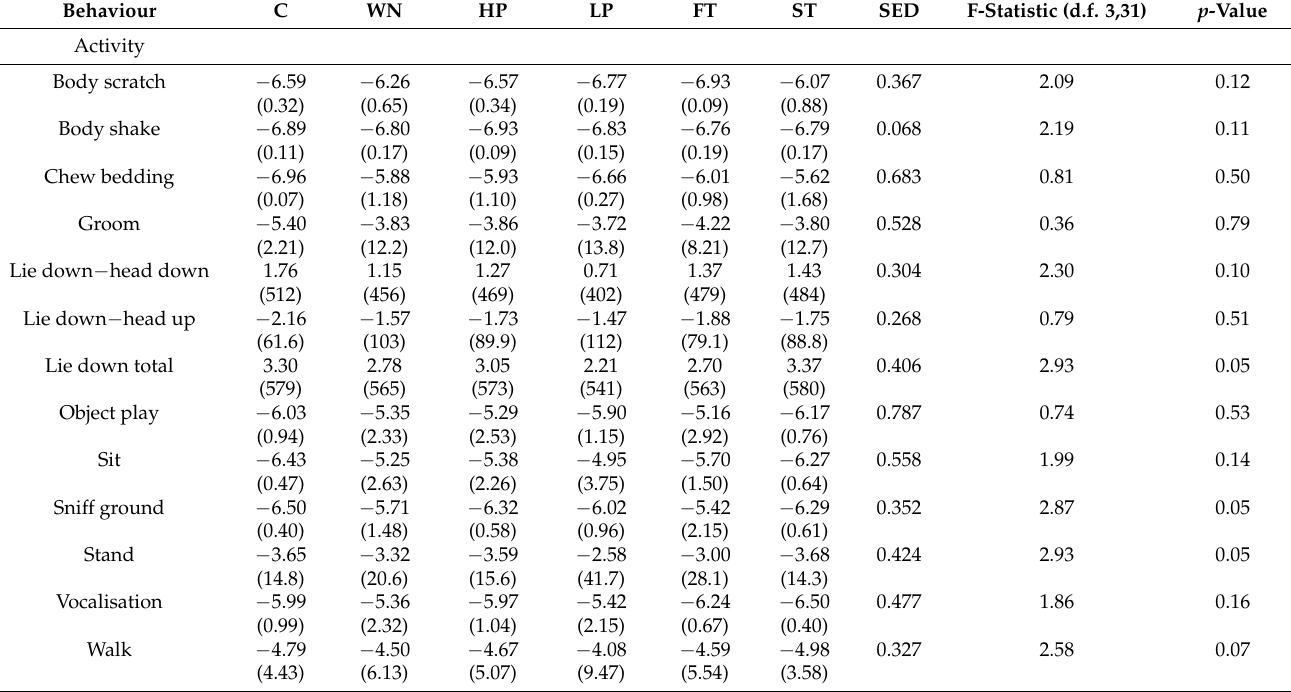
Table 3. The behaviour of dogs ( n = 10) exposed to a control, white noise, high pitch, low pitch, fast tempo, or slow tempo treatment for 10 min (600 s) over 10 days. All of the behaviours were logit transformed. Back transformed values to seconds are reported in parentheses. When multi-variable ANOVAs were significant ( p < 0.05), differences between individual treatments were examined using a Tukey test. Means that do not share a superscript letter are significantly different from each